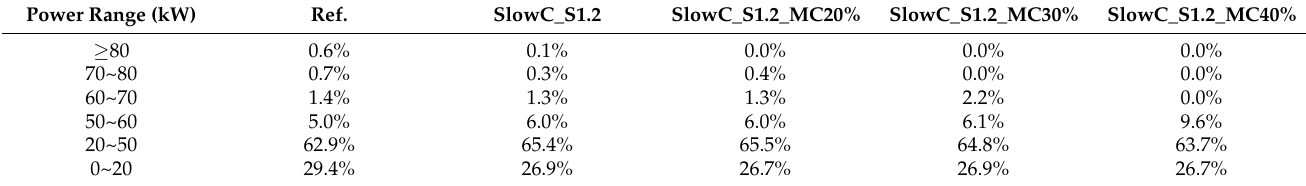
power duration ratio when the power is higher than 70 kW. It illustrates that the power is shifted from high-peak to off-peak periods. After 30% mass flow cutting, in order to sup- ply enough heat to the office building, the duration proportion of delivered heating power within 60 to 70 kW is 1 percentage unit higher compared with the reference, SlowC_S1.2 and SlowC_S1.2_MC20% cases. Similarly, in the range of 50 to 60 kW, compared with the reference, it increases 4.6 percentage units after 40% mass flow cutting. It is about 3.5 per- centage units higher than the cases with storage (SlowC_S1.2) and 20% or 30% mass flow Table 5. The duration proportions of delivered heating power ranges of the reference case and peak shaving cases with and without mass flow cutting during the heating season (14 October–7 May). Power Range (kW)